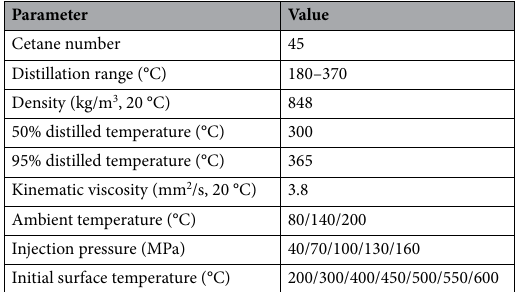
Table 2. Basic properties of 0 # diesel and experimental